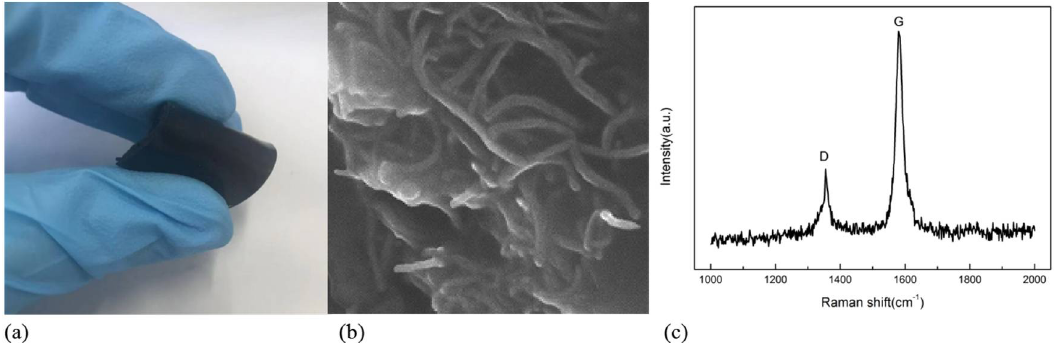
Figure 3. CNT/PDMS ( a ) physical diagram of force-sensitive structure ( b ) SEM diagram ( c ) test re- sults of Raman